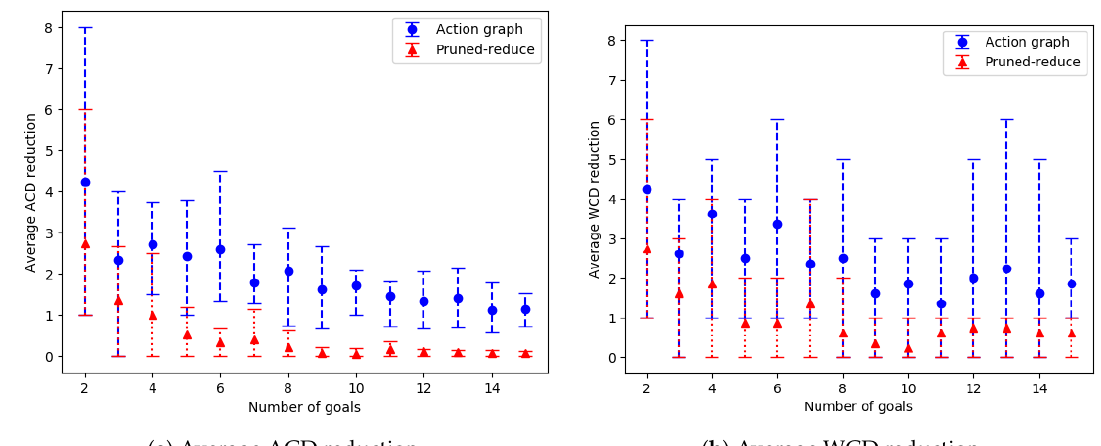
Figure A4. Results for an increasing number of goals. The results of our Action Graph approach are indicated by blue circles, pruned reduce [10] is shown with red